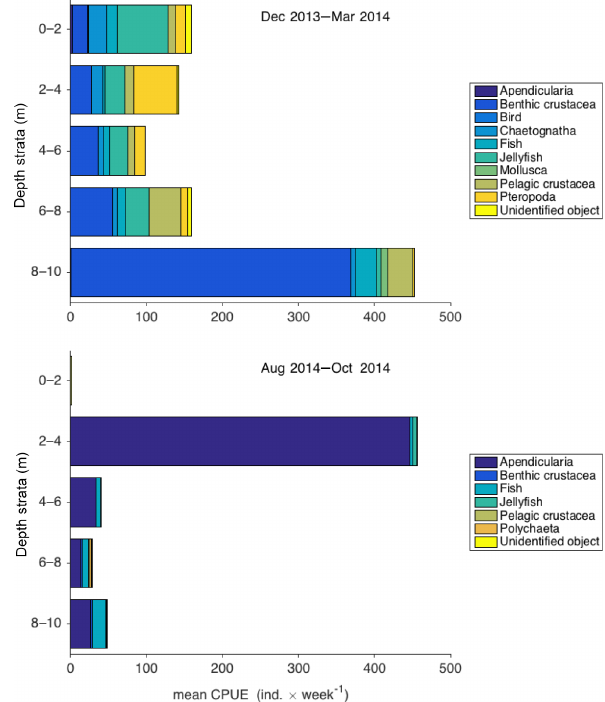
Figure 6. Vertical distribution of the different species groups over the water columns. For details with respect to “Catch per unit ef- fort”, see the